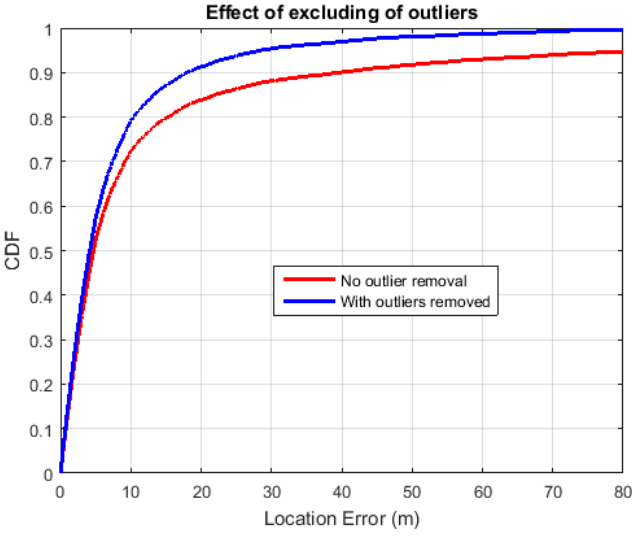
Figure 5. Outlier removal.